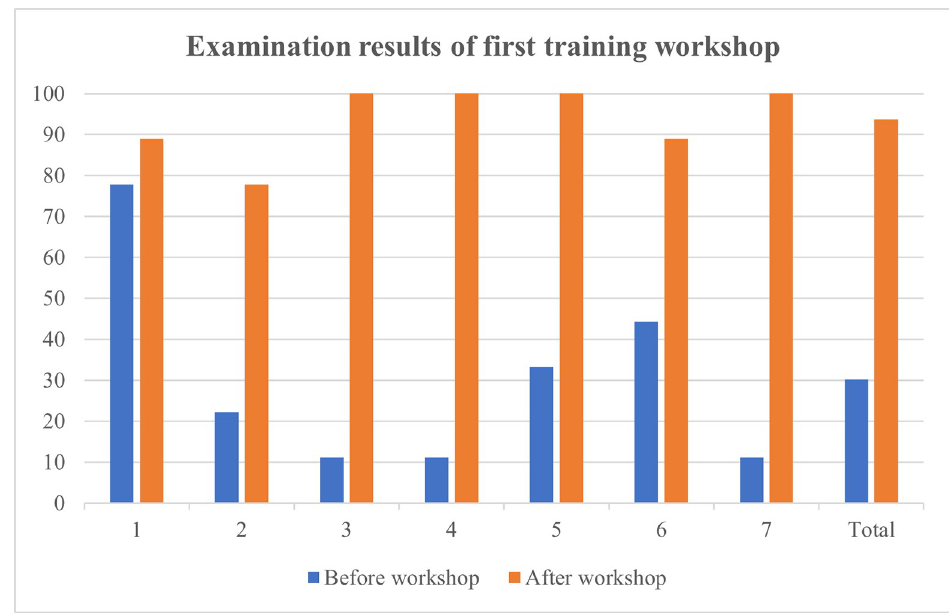
Fig 1. Comparison of participants’ knowledge assessment percentage results before and after the presentation of the first training workshop. 1 –participant 1; 2 –participant 2; 3 –participant 3; 4 –participant 4; 5 –participant 5; 6 – participant 6; 7 –participant 7.